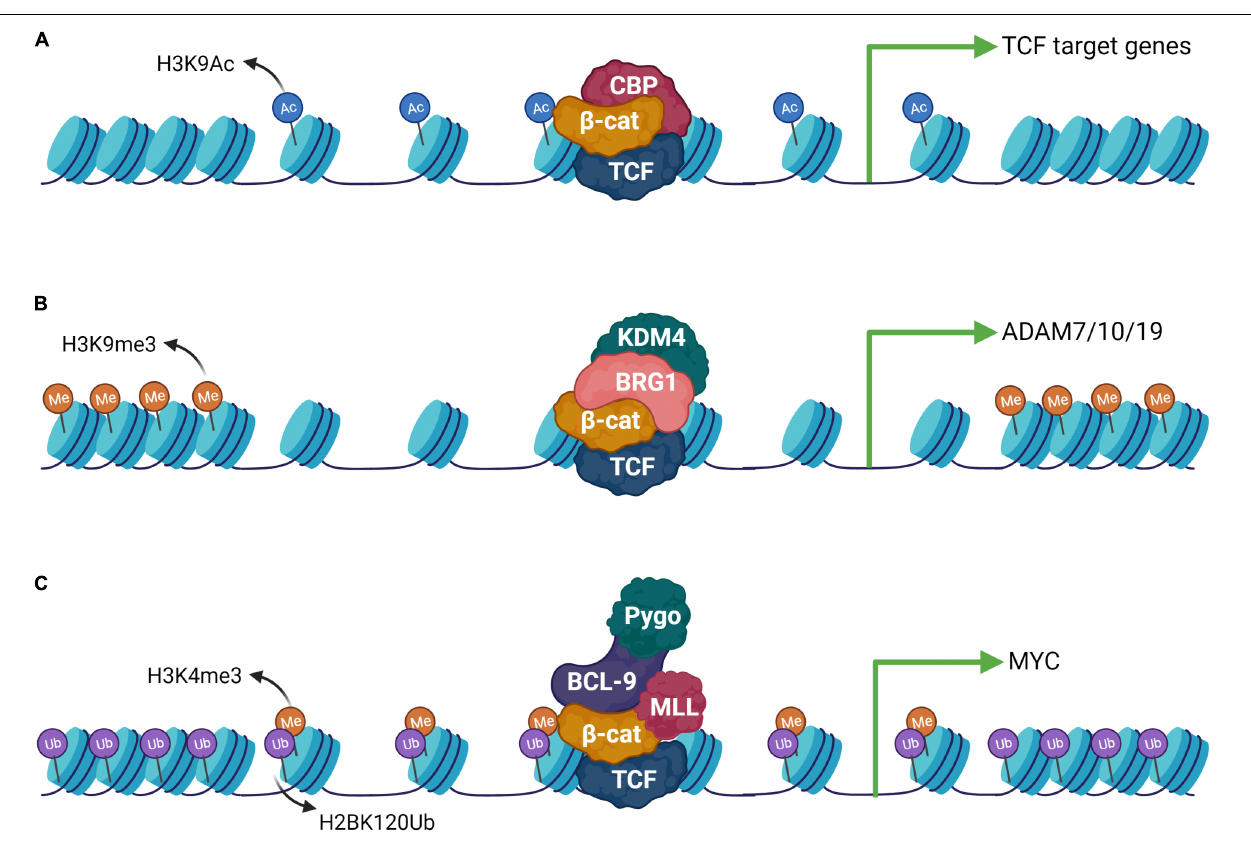
FIGURE 4 | Epigenetic machinery downstream to the Wnt signaling pathway. (A) β -catenin can form complexes with different epigenetic modulators and activate gene expression upon Wnt activation. CBP is a well-known interaction partner of β -catenin which helps in opening up of the chromatin by catalyzing H3K9 acetylation. (B) Histone demethylase KDM4 is recruited via BRG1, an interactor of β -catenin which stimulates the expression of the ADAM group of genes. (C) β -catenin can also form an elaborate complex with the chromatin remodelers composed of the MLL complex, Pygo and Bcl-9 leading to H3K4me3 modification. This activity requires prior ubiquitination of